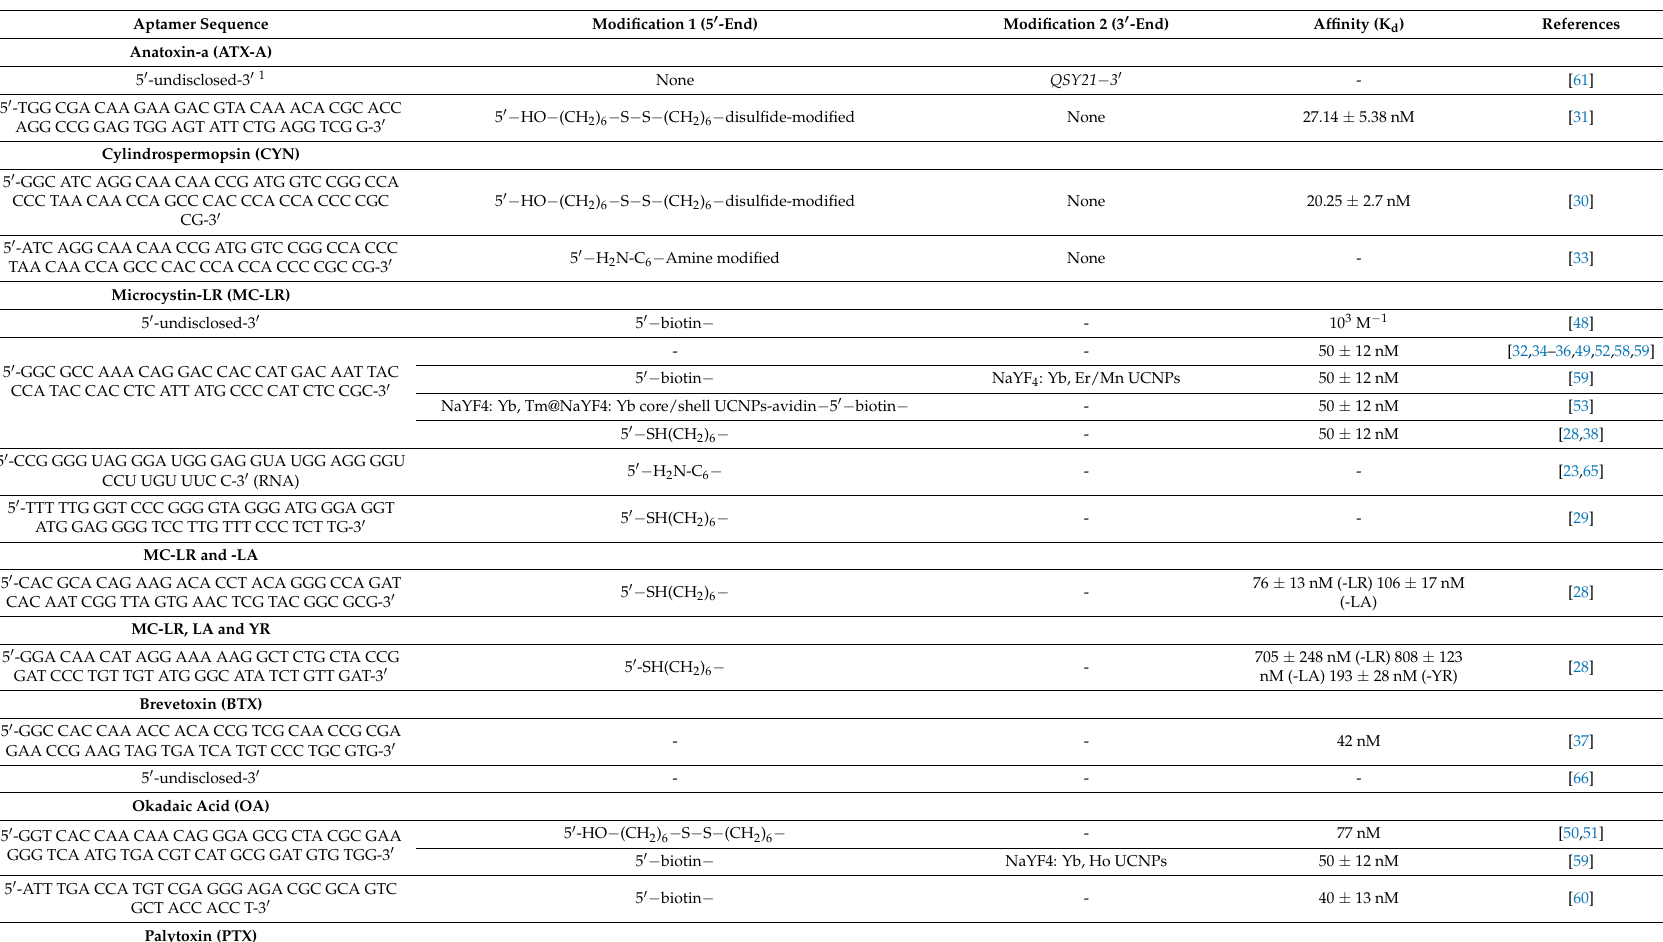
Table 3. Characteristics of the aptamers selected for the various aquatic phycotoxins and cyanotoxins, identifying modifications at 3’or 5 (cid:48) ends to label or link the aptamers to the sensor platform and affinity to the target toxin. Aptamer